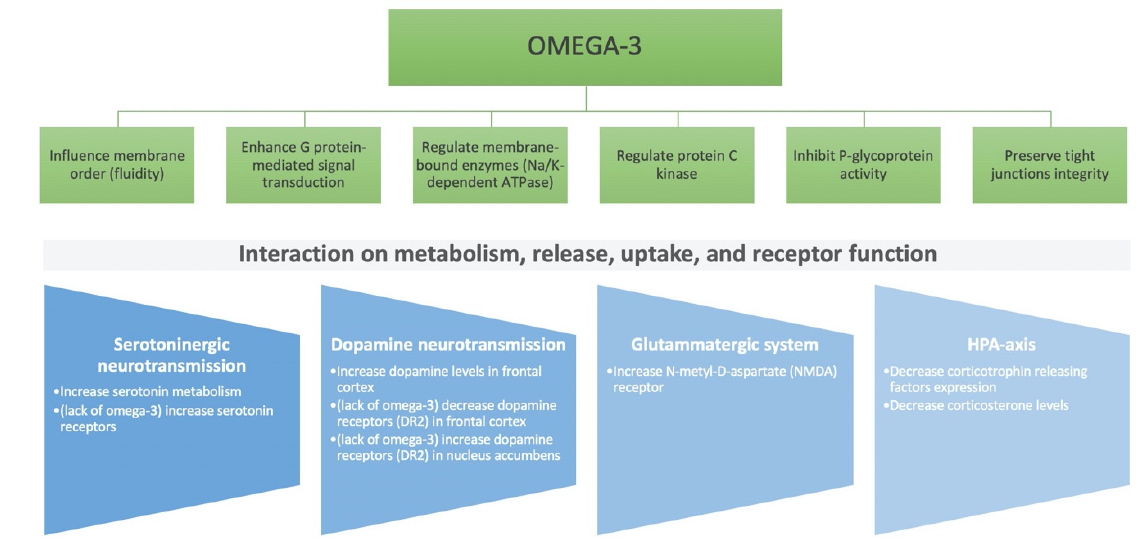
Figure 1. Neuroendocrine mechanisms of omega-3 polyunsaturated fatty acids effect on the central nervous system.